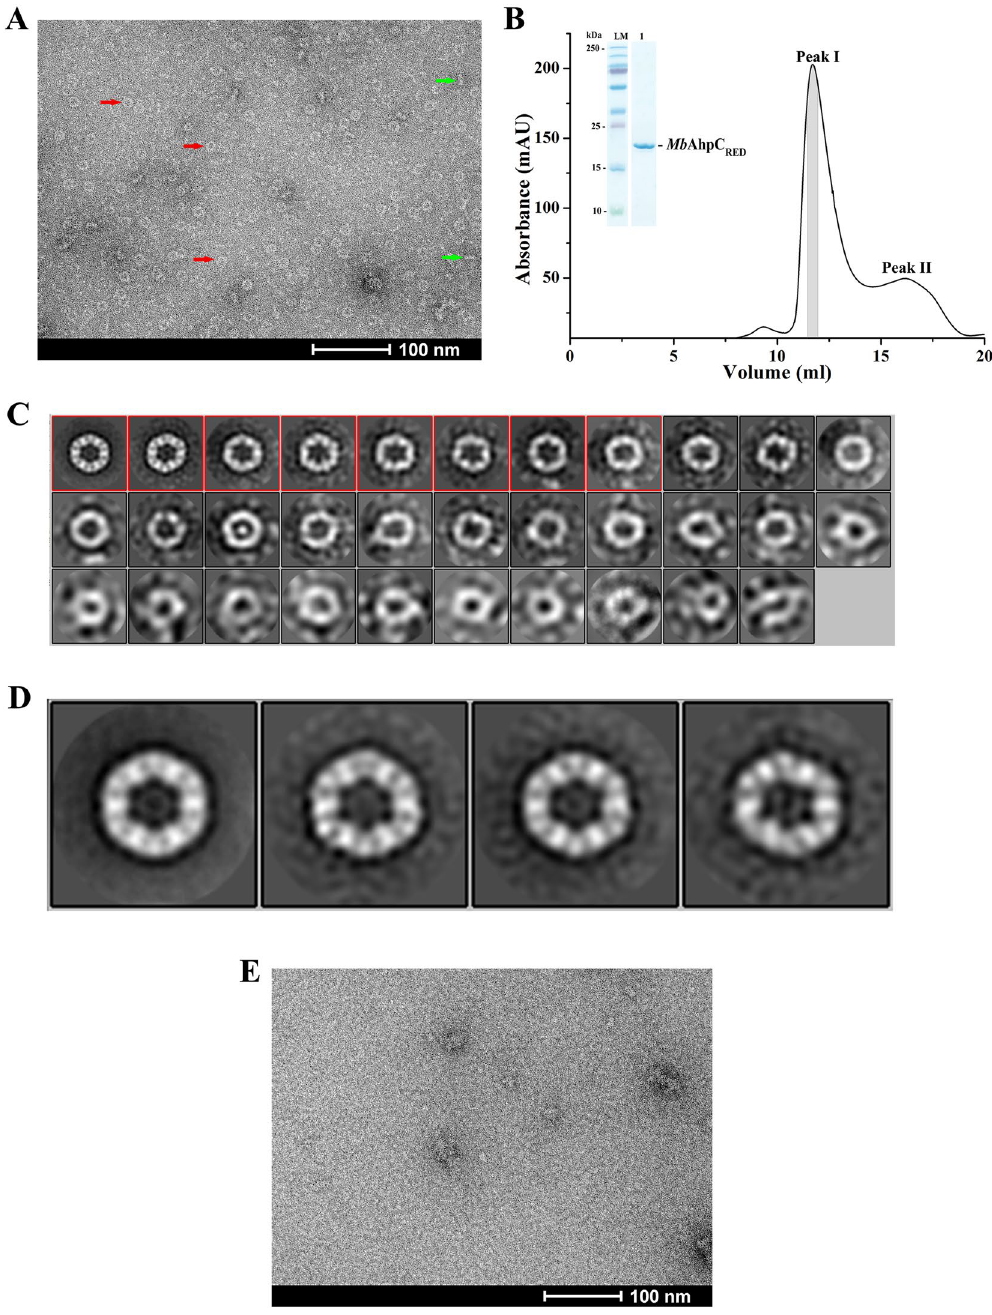
Figure 3. Negative stain electron micrographs of Mb AhpC. ( A ) Micrograph of Mb AhpC in its reduced form showed ring and rod shape particles, which were likely representing the top ( red arrow ) and side ( green arrow ) views of the ring structures, respectively. ( B ) The recombinant and reduced Mb AhpC eluted with majority of the protein fractions at approximately 12 ml on a Superdex 200 HR 10/30 column and showed high purity on a 17% SDS gel ( inset ). ( C ) 2D classification of Mb AhpC particles in its reduced form. Raw particles were classified in 32 classes employing 2D classification procedure of RELION image processing package. ( D ) Projection analysis revealed a dodecameric Mb AhpC. Particles from the boxed classes in C were further classified into 4 classes to improve the quality of 2D classification. ( E ) The ring-shaped particles seen in the micrographs of reduced Mb AhpC above were absent in the micrograph of the oxidized